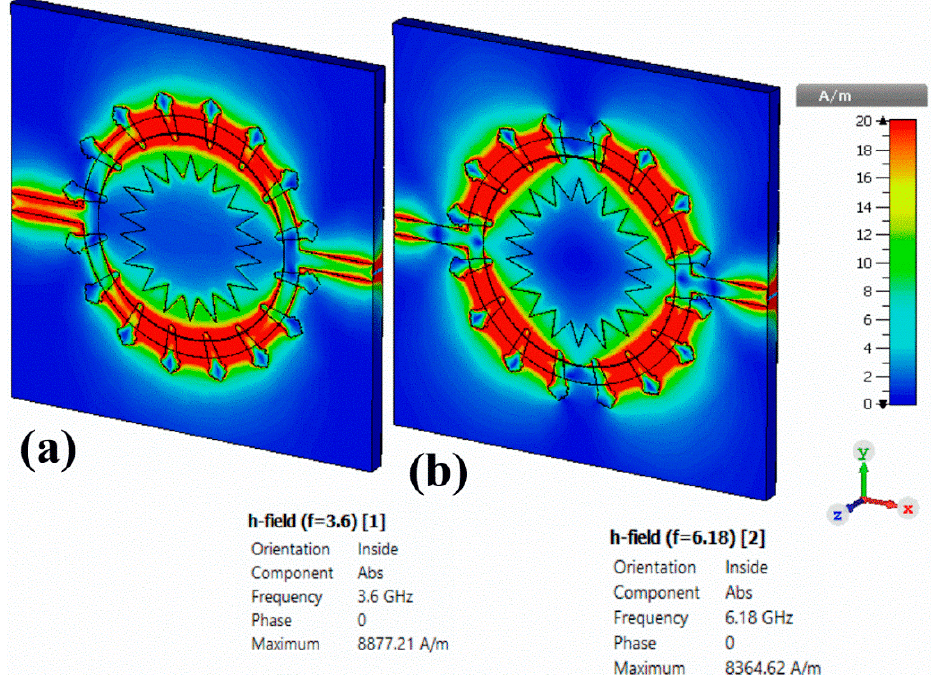
Figure 18. Electric field distribution for the proposed corona-shaped sensor at two different resonance frequencies: ( a ) 3.6 GHz and ( b ) 6.16 GHz.